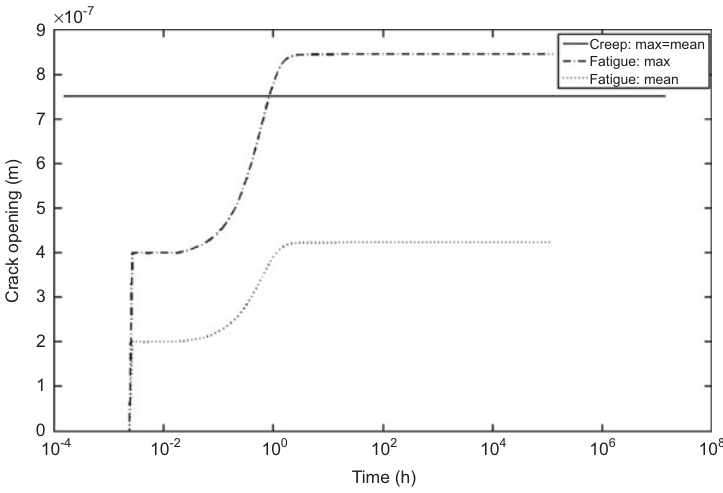
Figure 1 Maximum and mean crack opening for fatigue and creep loading.